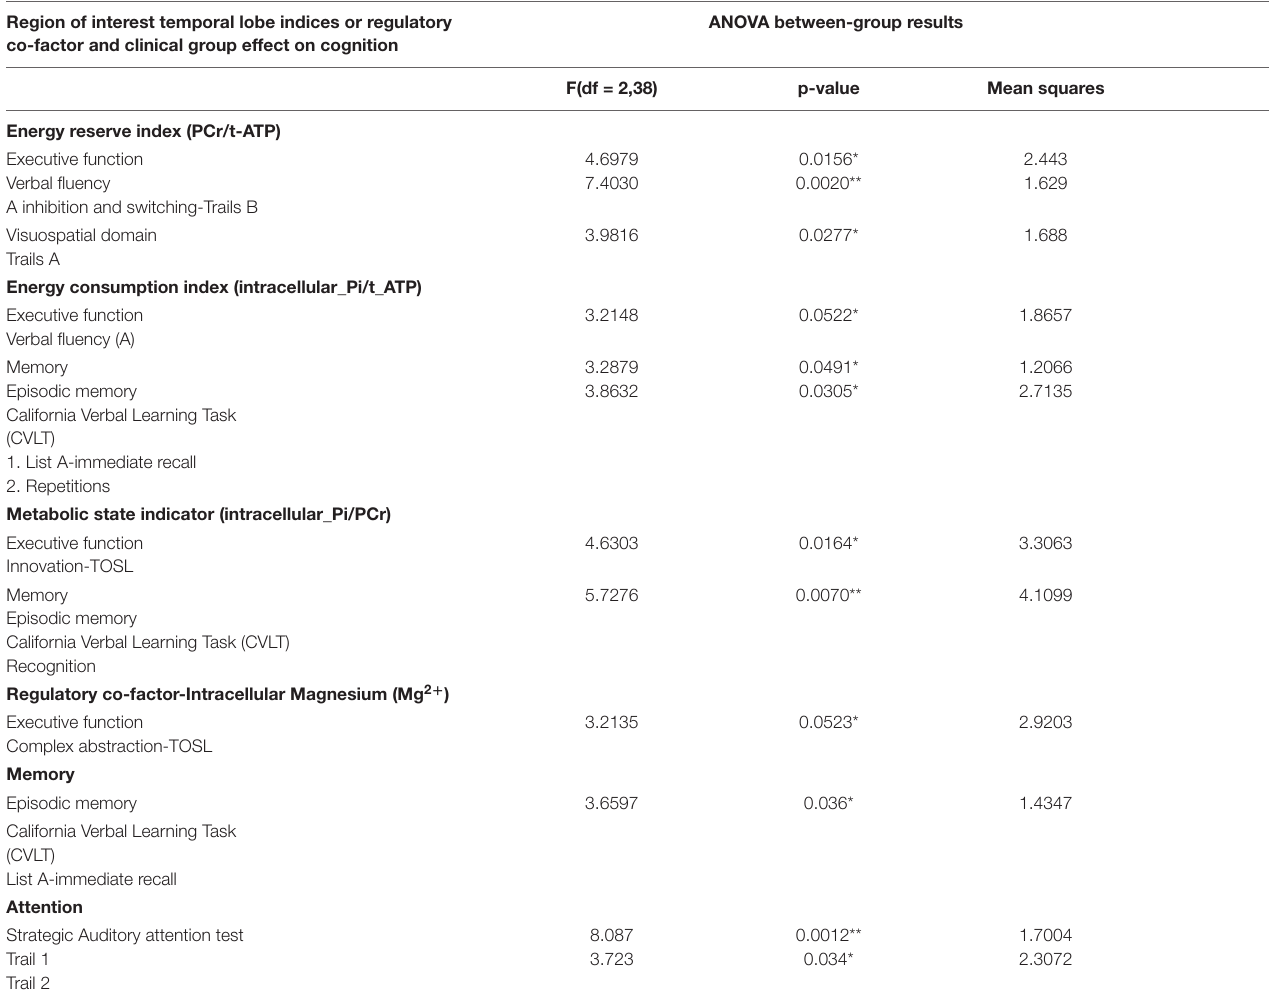
TABLE 4 | Main effect of BEM and regulatory co-factor (Magnesium 2 + ) interaction with the clinical group on cognitive performance of domains of executive function, memory, attention, visuospatial skills, and language. Region of interest temporal lobe indices or regulatory co-factor and clinical group effect on cognition